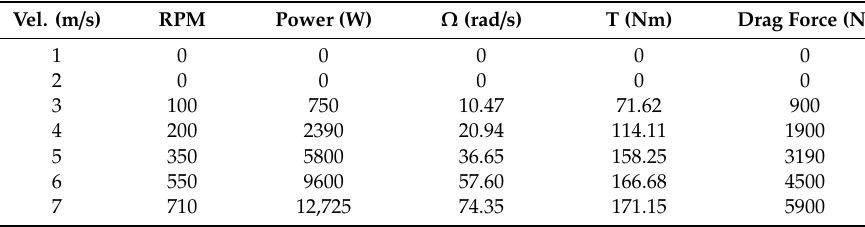
Table 3. Mechanical Load output of 4.7 Ω .